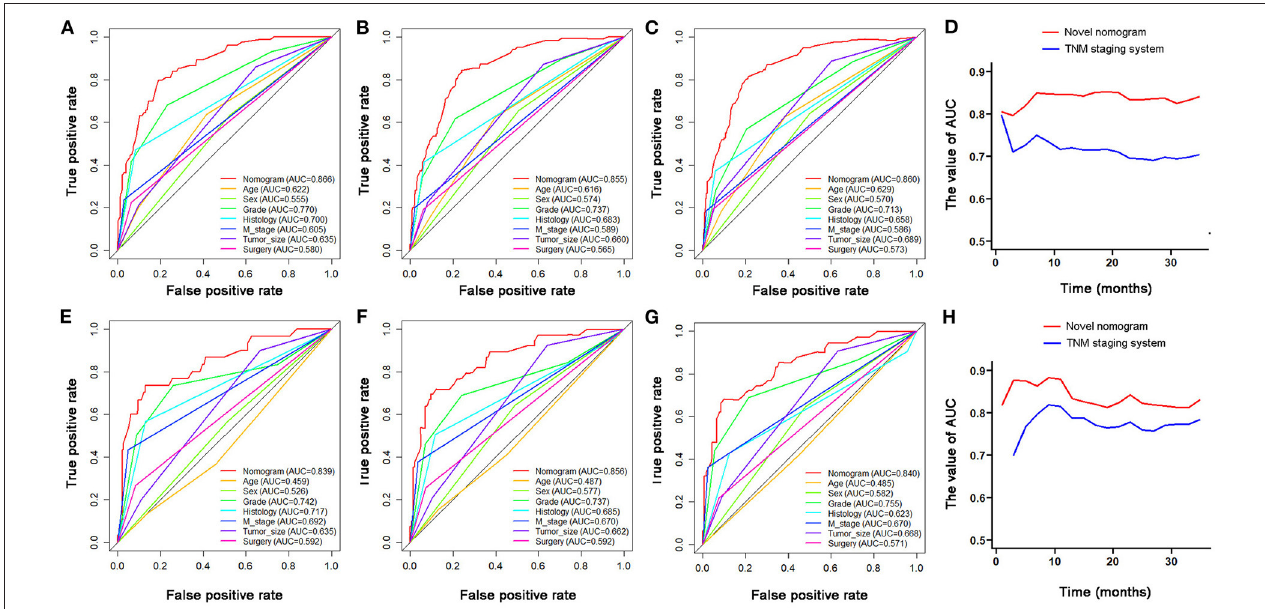
FIGURE 5 | The comparison of ROC curves between nomogram and independent predictors at 12- (A) , 24- (B) , 36-month (C) , in the training group and at 12- (E) , 24- (F) , and 36-month (G) in the validation group. The time-dependent ROC curves of the nomogram for OS prediction in training group (D) and validation group (H) .